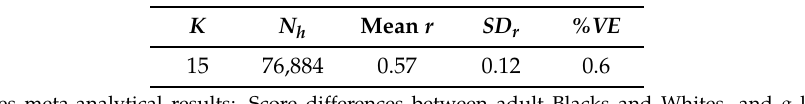
Table 4. Exploratory Bare Bones Meta-analytical Results for Correlations between g Loadings and Adult Black/White